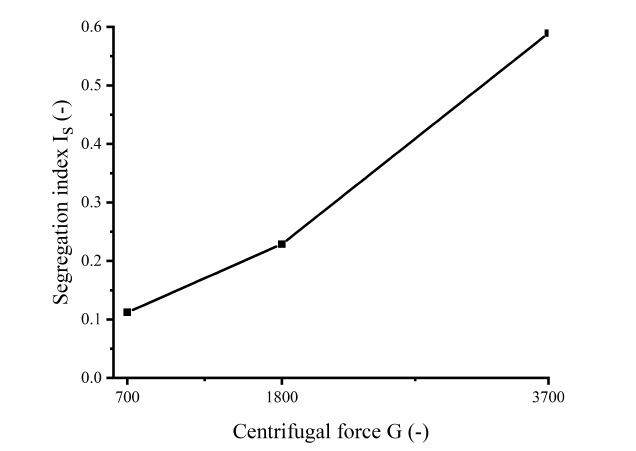
Figure 11. Variation of segregation index with centrifugal